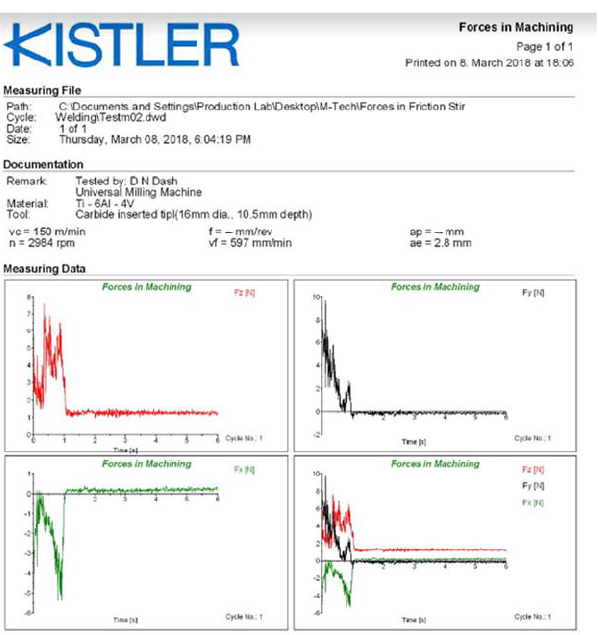
Figure 5. Reading obtained using tool dynamometer for various components of forces .